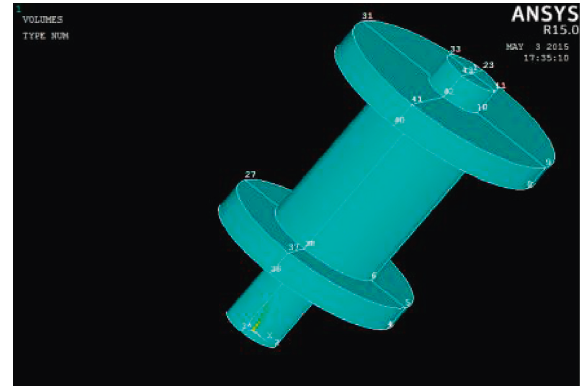
Figure 14: Model of aerostatic Table 3: First 6-order frequency of spindle in two cases. Orders 1 Original parameters (Hz) 494 496 1439 4857 4876 5591 Optimization (Hz)